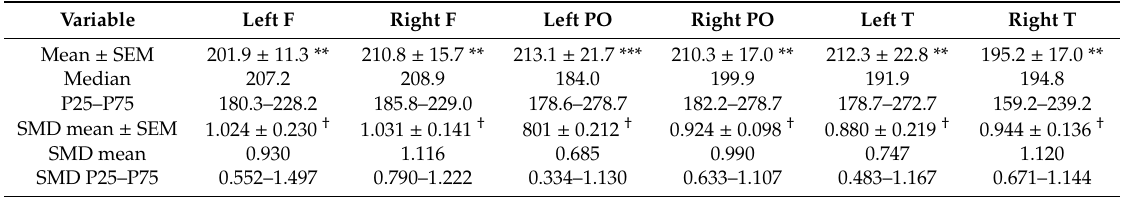
Table A3. Changes in power of alpha bands during GS.